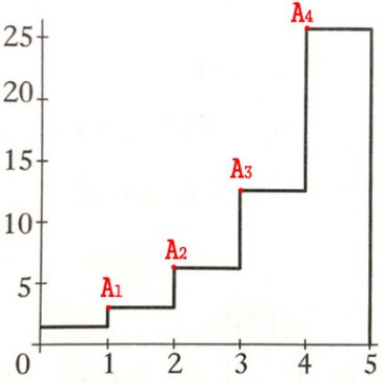
Figure 7. The Jiuzhang Suanshu : about problem four on the proportional distribution ( Cuifen ), a graph for the solution on “weaving woman as skillful weaver”.